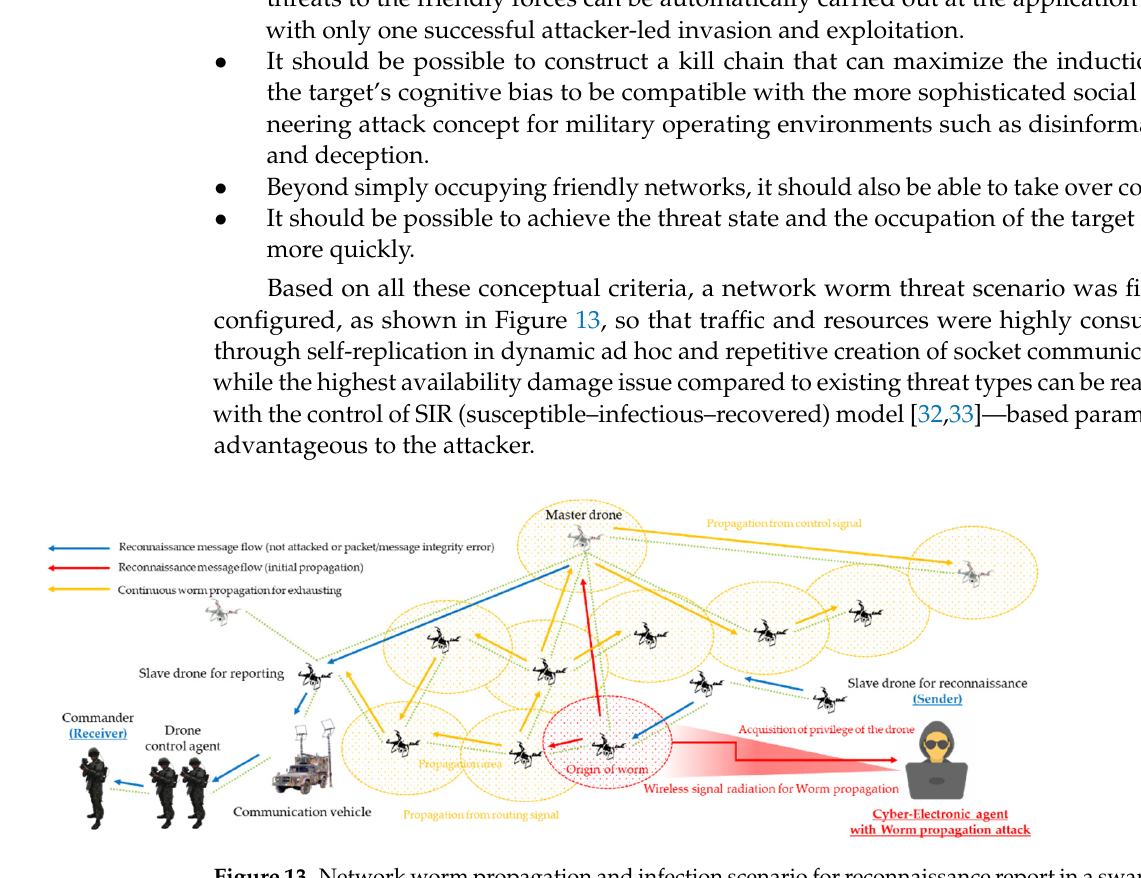
Figure 13. Network worm propagation and infection scenario for reconnaissance report in a swarming communication drones maneuvering system.